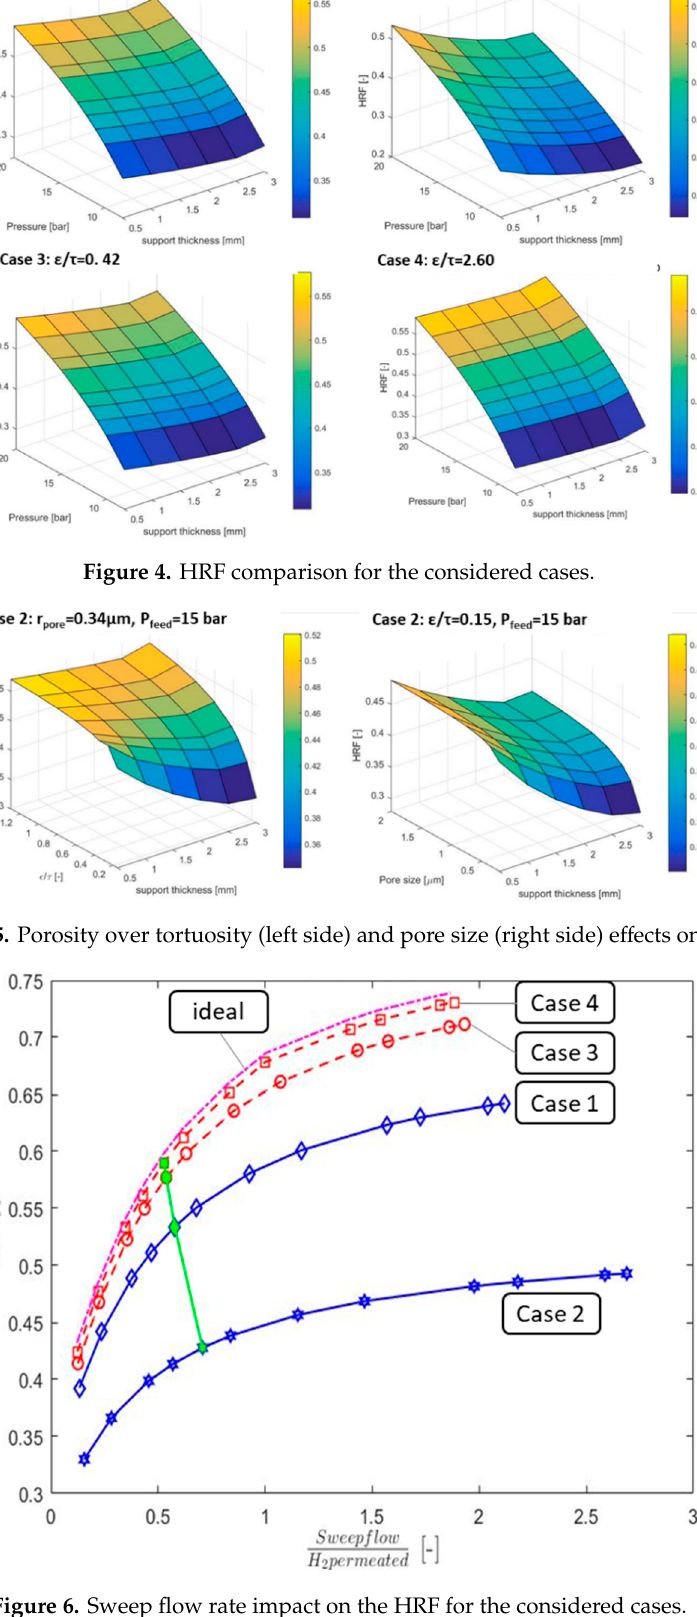
Figure 6. Sweep flow rate impact on the HRF for the considered cases.